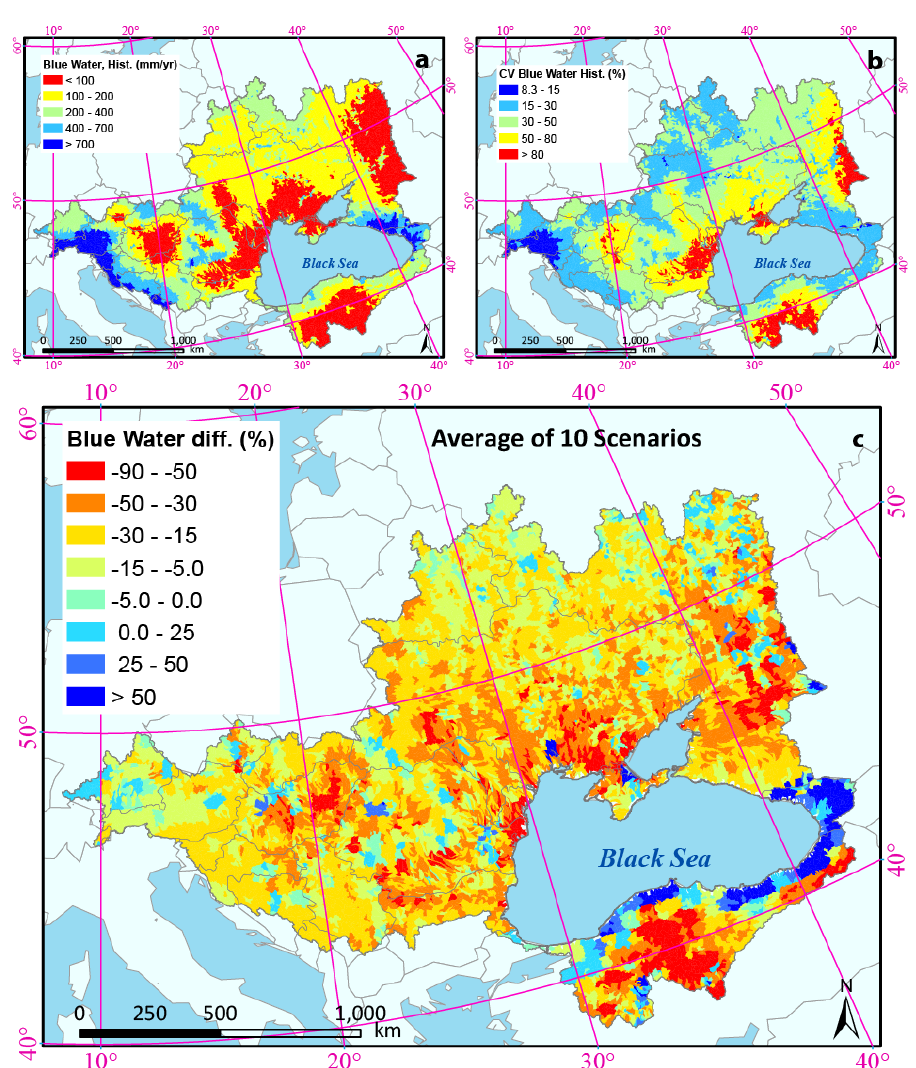
Figure 7. Spatial distribution of blue water resources in the Black Sea Catchment: ( a ) long-term historical average (1973–2006); ( b ) temporal variation of historical blue water; ( c ) percent deviation